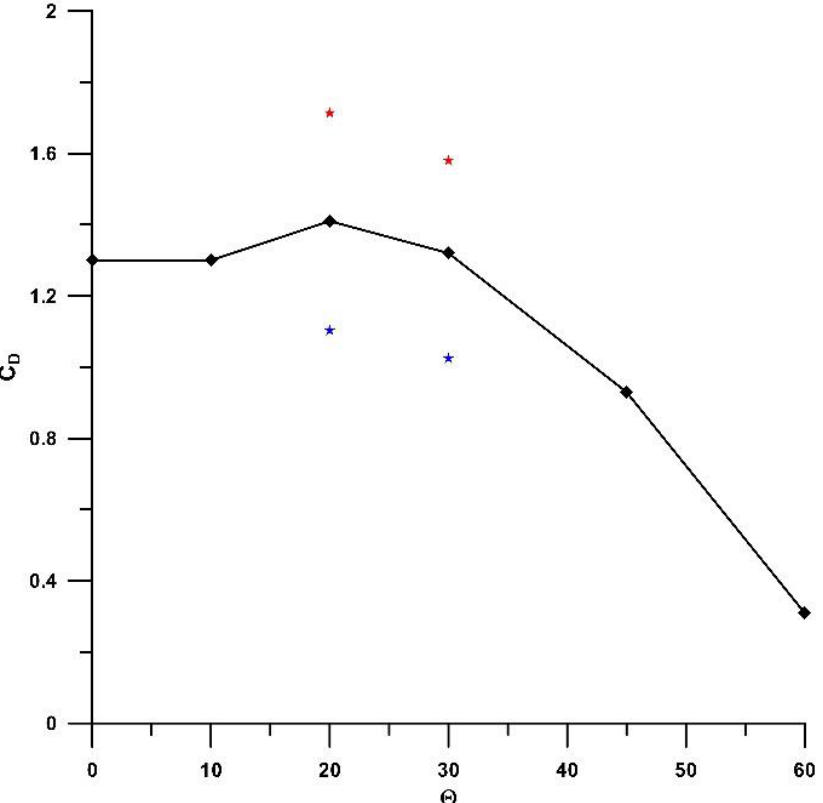
Figure 12. Arch drag coefficient for varying incidences.